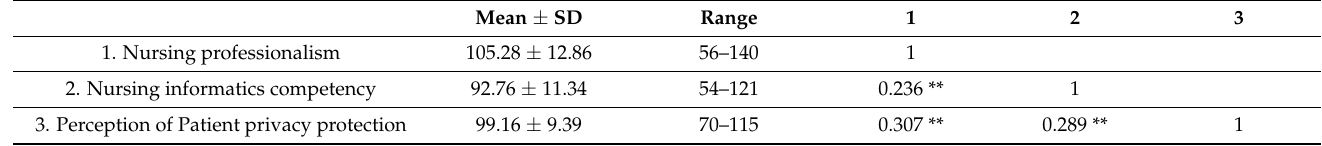
Table 2. Descriptive statistics and correlation among the main